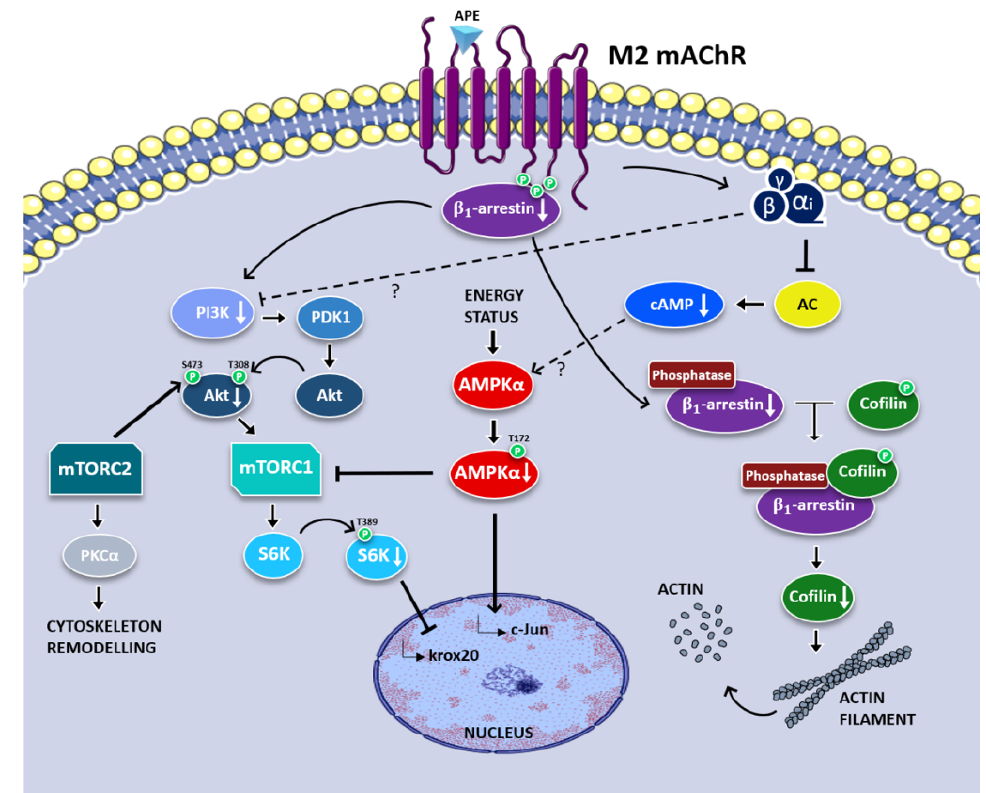
Figure 1. The signal transduction pathways activated downstream of the M2 muscarinic receptors mainly involve G α i with cAMP level reduction. However, M2 receptors can also negatively modulate the PI3K/AKT/mTORC1 pathway via a β 1-arrestin decrease or βγ subunits. All these signals may contribute to negatively modulate SC proliferation and to promote their differentiation [75].